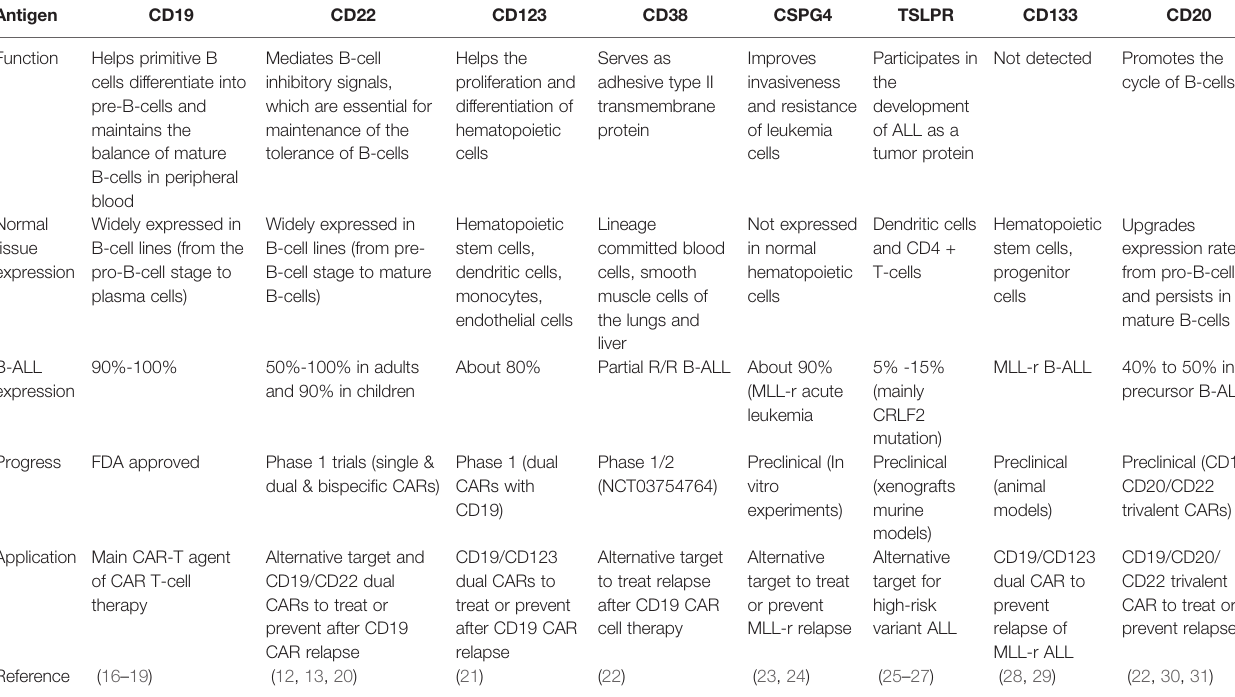
TABLE 2 | Target antigens of CAR T-cell